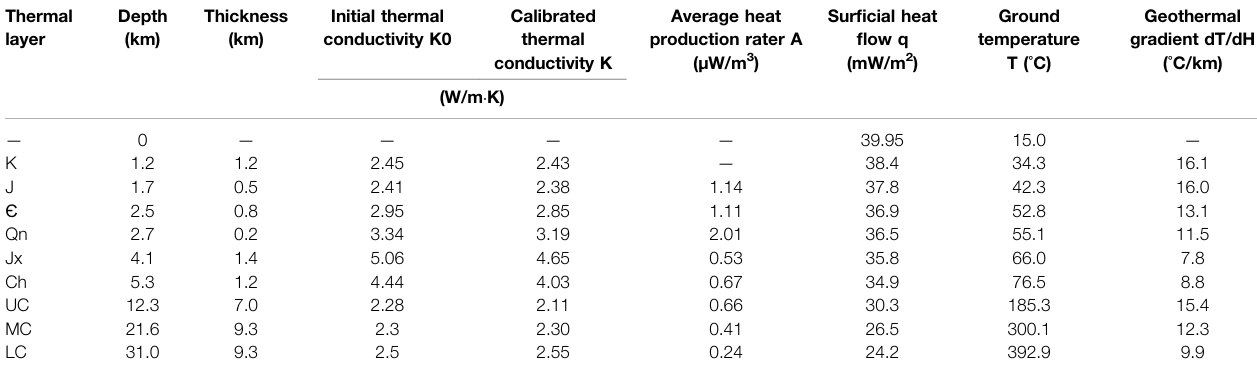
TABLE 5 | Deep temperature distribution in the Yanheying Basin. Thermal Depth layer